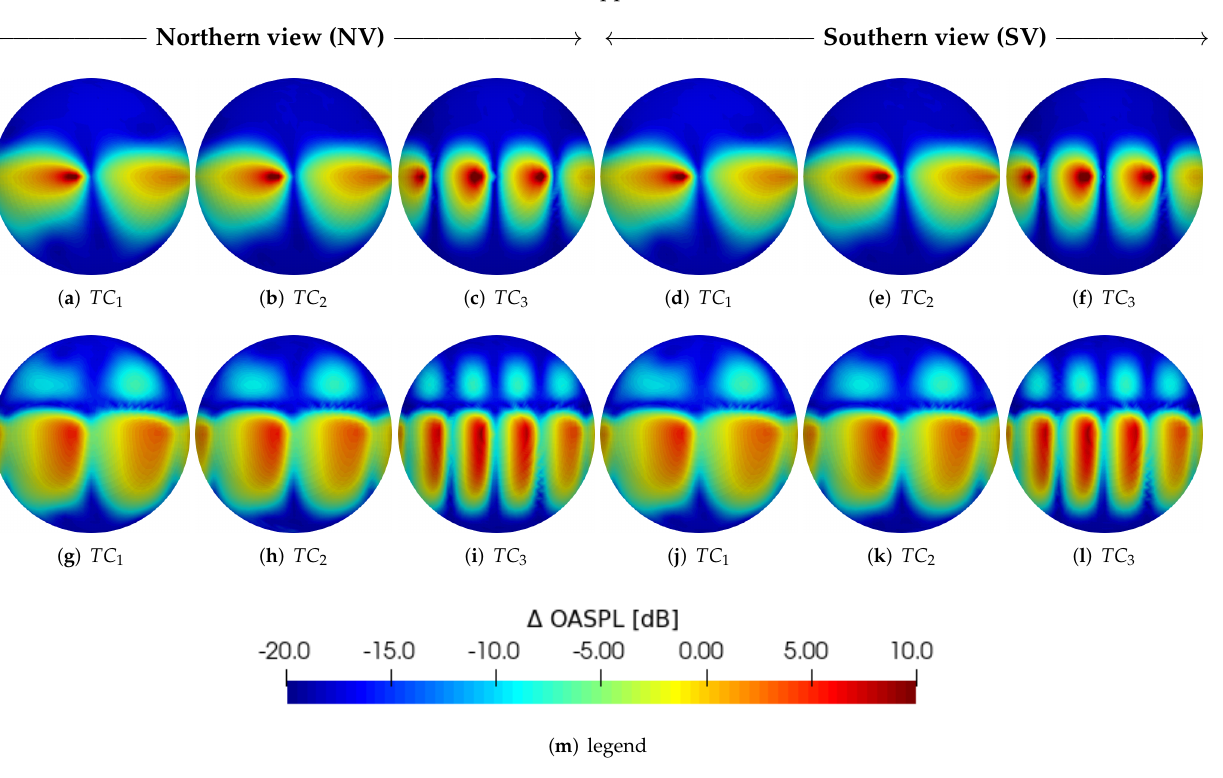
Figure 9. Co-rotating configuration, difference between far-field and near-field OASPL for the defined TCs and for M t = 0.52 (upper) and M t = 0.7